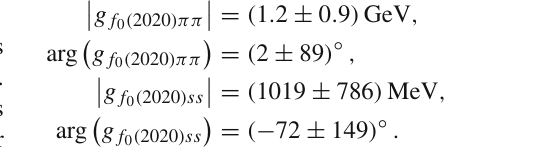
cise) branching ratio quoted by the PDG, B f